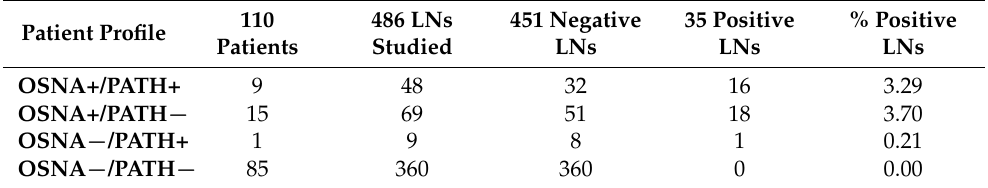
Table 2. Characteristics of LNs of 110 patients included in the